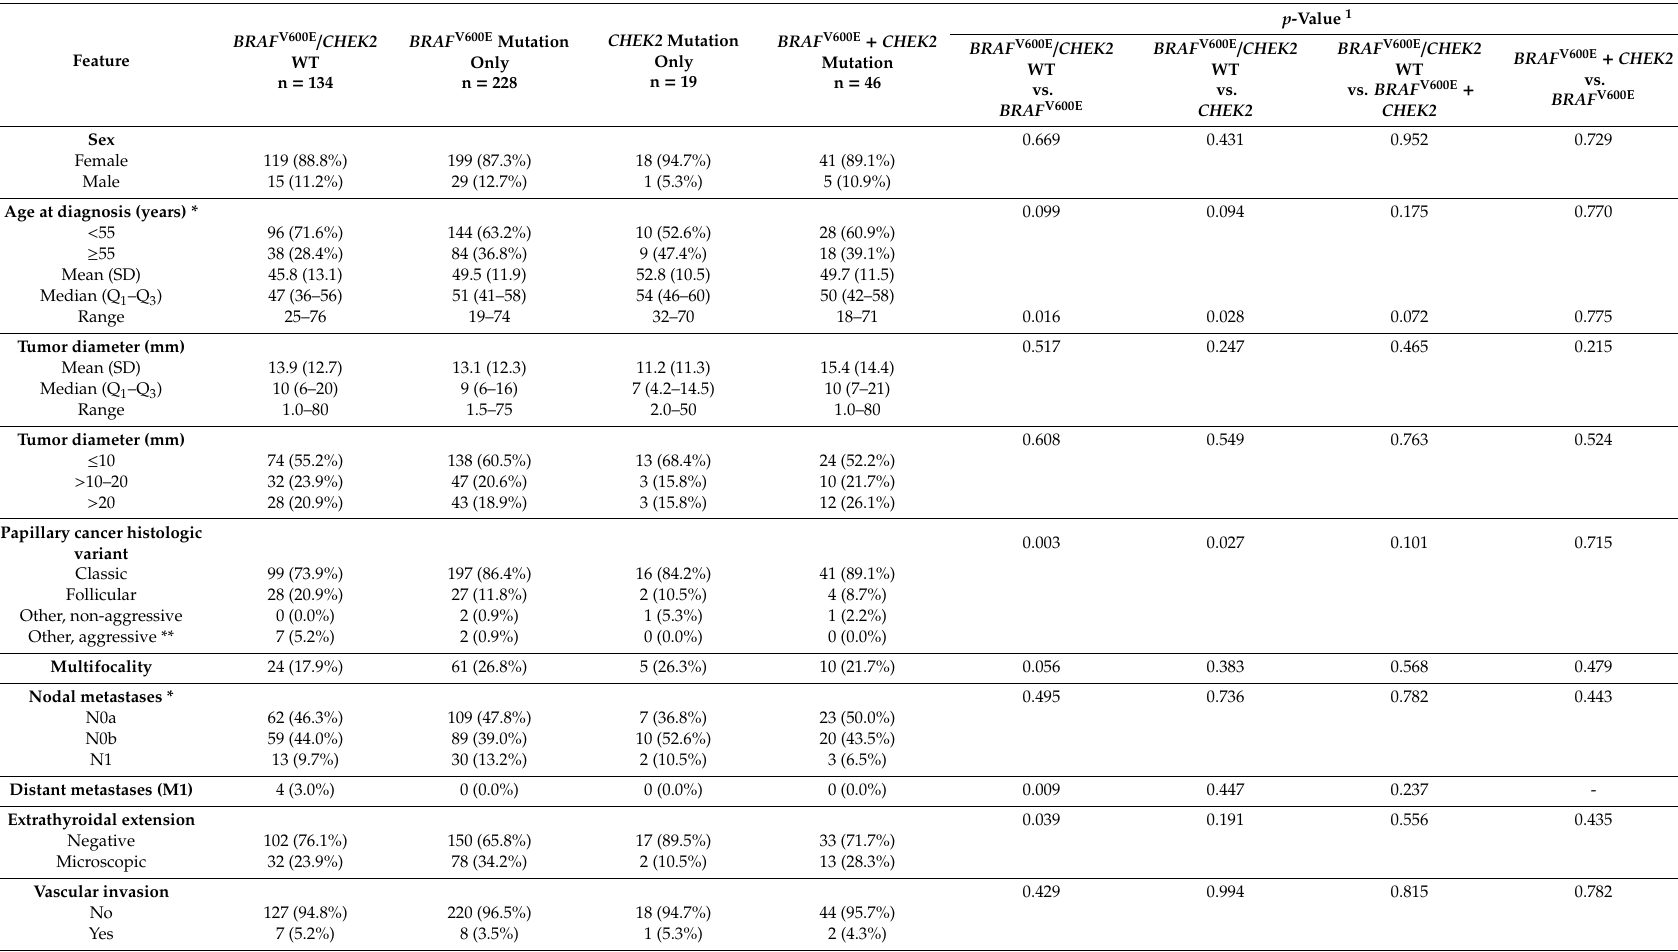
Table 3. Impact of BRAF V600E or CHEK2 mutations or their coexistence on clinicopathological characteristics, response to therapy, and disease